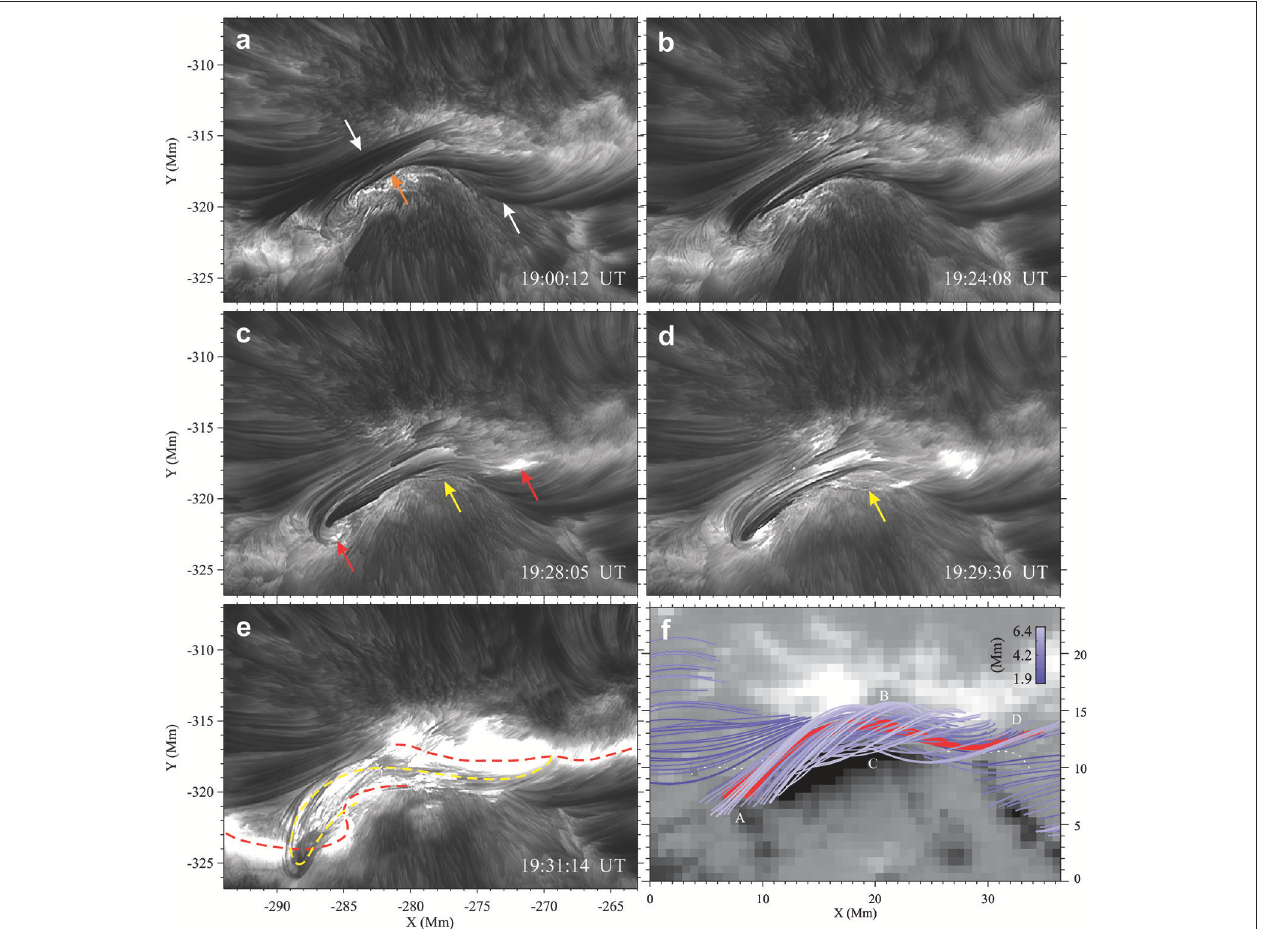
FIGURE 1 | BBSO/GST H α time-sequence observations (a–e) and NLFFF modeling (f) of a magnetic flux rope in NOAA active region 11817 on 2013 August 11. The white (orange) arrows point to the weakened (enhanced) loops at the event onset, and the red arrows indicate the initial footpoint brightening. The yellow arrows and dashed line delineate the active flux rope in motion, and the red dashed line mark the induced double ribbons of a C2.1 flare. The plotted representative field lines are from a preflare optimization NLFFF extrapolation model, which is based on the SDO /HMI vector magnetic field data remapped with a Lambert cylindrical equal area projection. The twisted flux rope in red (with a maximum height . 4.0 Mm) is embedded in sheared arcade fields (largely AB and CD) in blue (with a maximum height . 6.4 Mm) (Wang et al., 2015). Credit: Nature